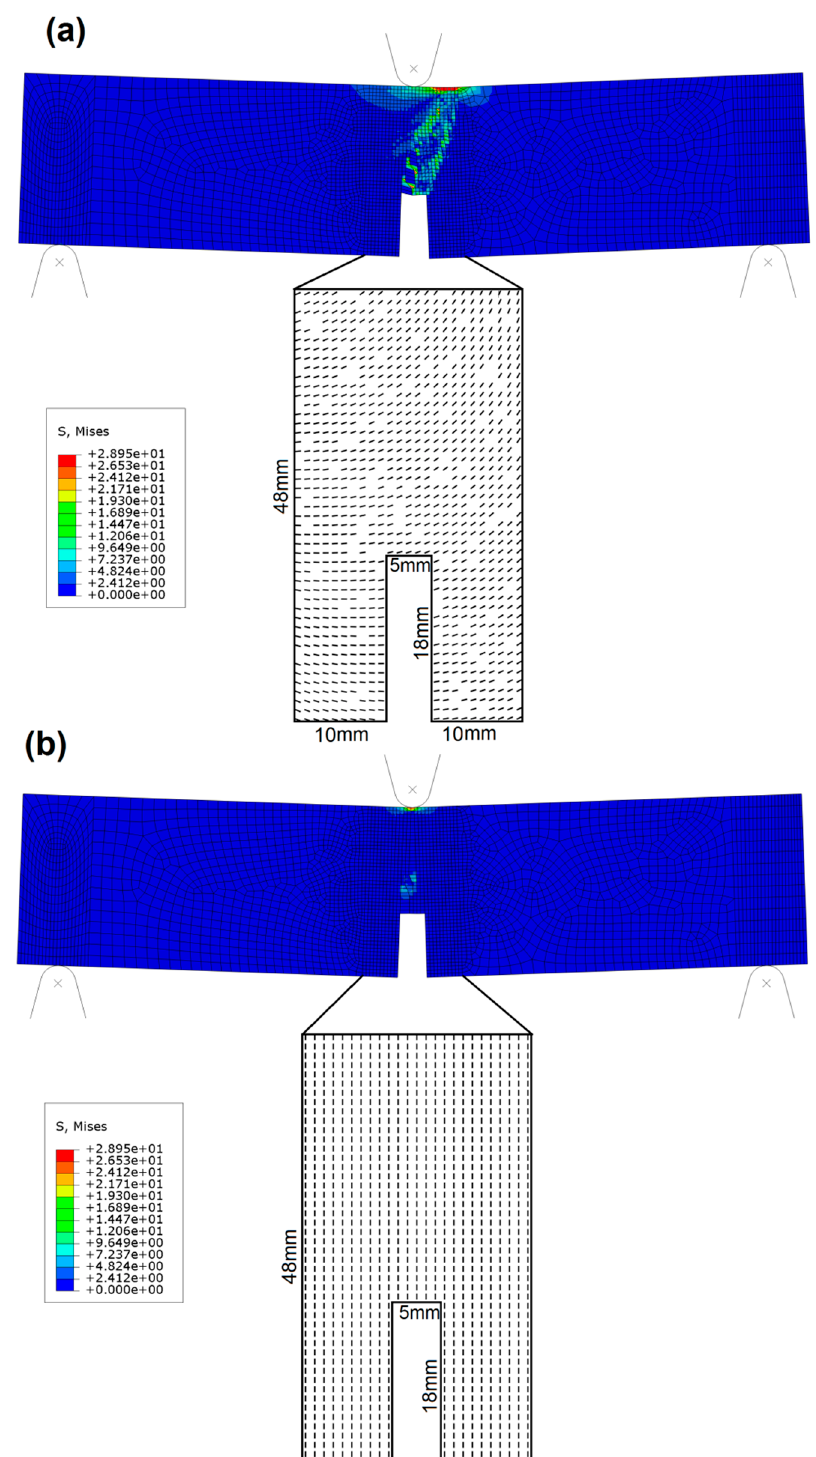
Figure 4. Two numerical models of the three-point bending test with different fiber orientations. ( a ) model with gradually changing fiber orientations, ( b ) model with all fibers oriented perpendicular to the longitudinal axis of the beam.